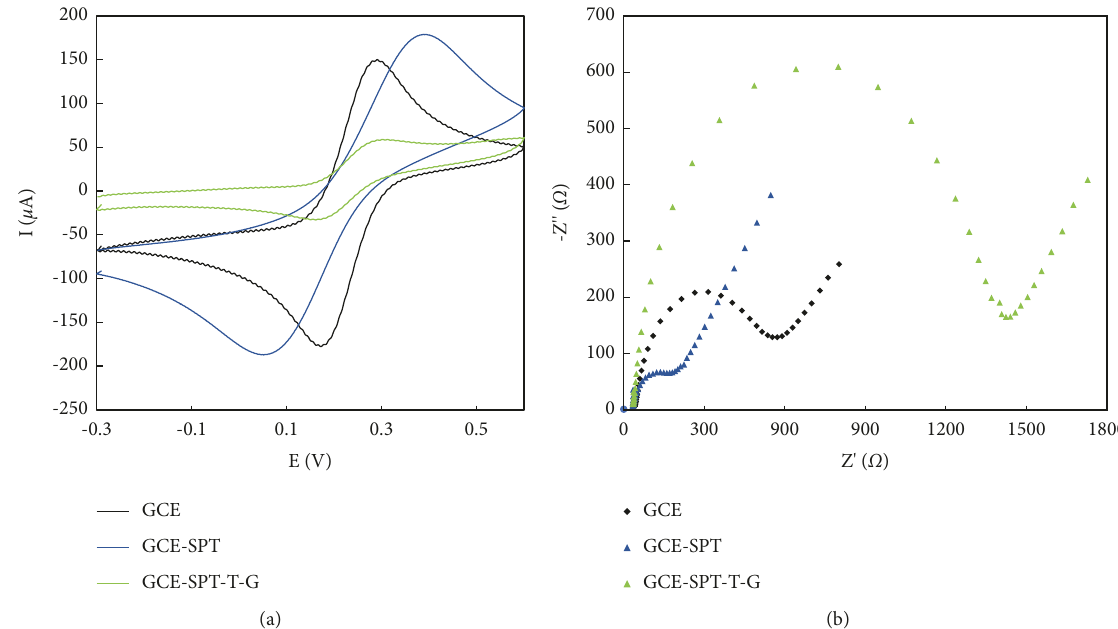
Figure 5: (a) CV curves and (b) Nyquist plots of bare GCE and modified GCE with STP and